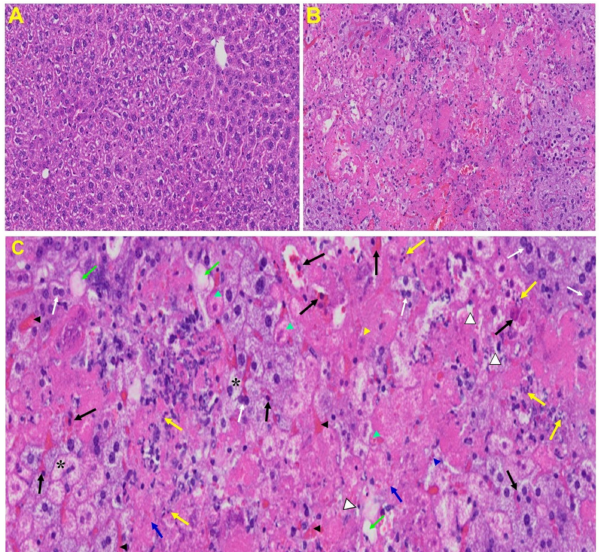
Figure 6. Liver from MHV-1 exposed mice. ( A ) Normal mouse. ( B ) Infected mouse liver at day 7. ( C ) The MHV-1 infected mouse liver at day 7 shows hepatocyte degeneration (yellow arrows), severe periportal hepatocellular necrosis with pyknotic nuclei (black arrows), severe hepatic congestion (black arrowheads), ballooned hepatocytes (asterisks), vacuolation (green arrows), and the presence of piecemeal necrosis (blue arrowhead), as well as hemorrhagic changes. Ground glass hepatocytes show voluminous, abundant, granular cytoplasm, peripheral cytoplasmic clearing and central nuclei, and apoptotic (acidophil) bodies. Several hepatocytes are absent and have been replaced by abundant inflammatory cells (yellow arrowhead). Note the condensation and dark staining of the cytoplasm and the absence of the nucleus (green arrowheads), fatty changes (blue arrows), binucleated hepatocytes (white arrows), and activated Kupffer cells (white arrowheads), indistinctive of severe liver failure (H&E original magnification of A&B is 400 × as noted in Figure 5B). Brain : Upon examination of the MHV-1 infected mice brain (Figure 7B,C), we observed congested blood vessels, perivascular cavitation (suggestive of edema), pericellular halos, vacuolation of neuropils, darkly stained nuclei and pyknotic nuclei amid associated vacuo- lation of the neuropil, and acute eosinophilic necrosis. The brain hippocampus of MHV-1 infected mice showed necrotic neurons with fragmented nuclei and vacuolation (Figure